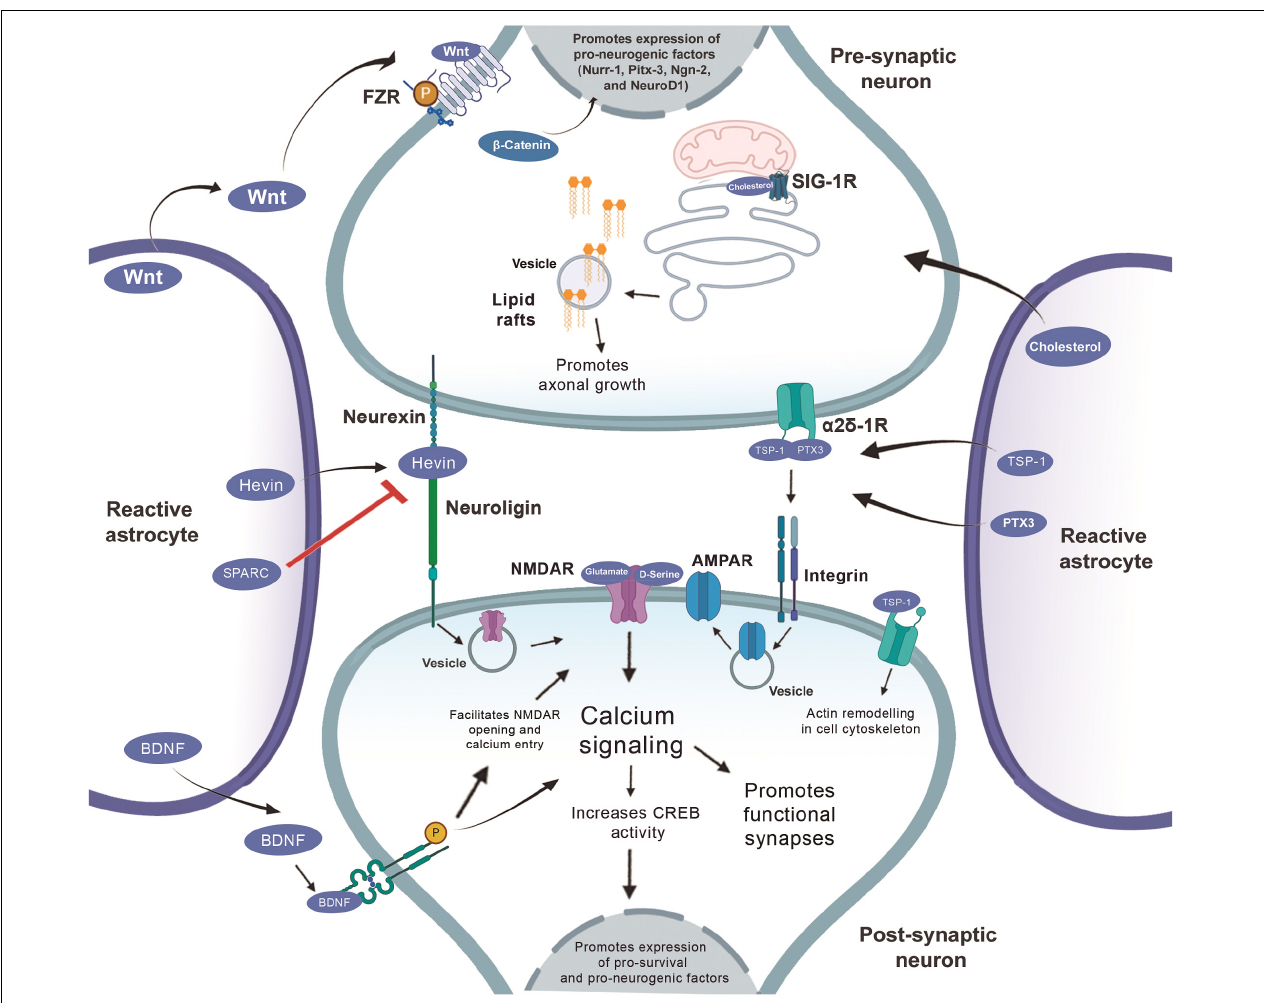
FIGURE 6 | Role of reactive astrocytes in neurorepair in the context of injury and the neurogenic and synaptogenic factors involved in this process. Wnt secreted by the reactive astrocyte interacts with the Frizzled receptors (FZR) and activates the b -catenin that will act inside the nucleus promoting the expression of pro-neurogenic genes (Nurr-1, Pitx-3, Ngn-2, and NeuroD1). BDNF activity at TRkB receptors increases calcium signaling, both by increasing CREB activity which, by acting on the nucleus, also promotes the expression of pro-survival and pro-neurogenesis factors, in addition to promoting the formation of functional synapses. D -serine acts similarly via NMDA receptor and CREB activation to promote such factors. TSP1 and PTX3 bind to the α 2 δ 1 receptor, this binding at the presynaptic site increases the number of synapses, but they are silent, so the PTX3 molecule released together with TSP promotes the functional maturation of these synapses through the recruitment of AMPA receptors. The binding of TSP to postsynaptic receptors, activates the Rac1 protein and stimulates the remodeling of actin to promote synaptogenesis. Hevin makes the connection between neurexin and neuroligin and, thus, increases the recruitment of the PSD95 and NMDAR subunits. Hevin’s effect is antagonized by SPARC. The cholesterol released by the astrocyte binds to the sigma-1 receptor and promotes axonal